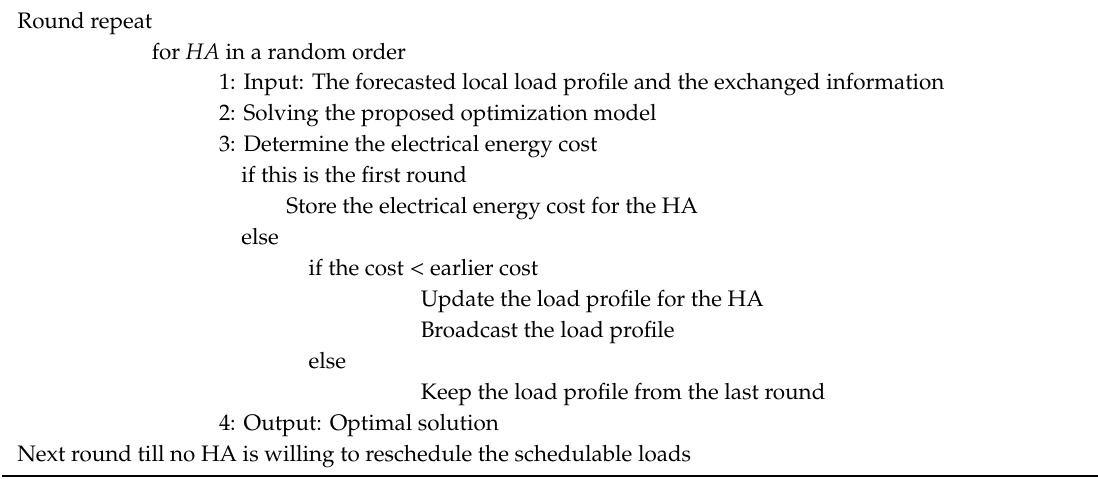
Algorithm 1. The algorithm for the multi-agent optimization model. Round